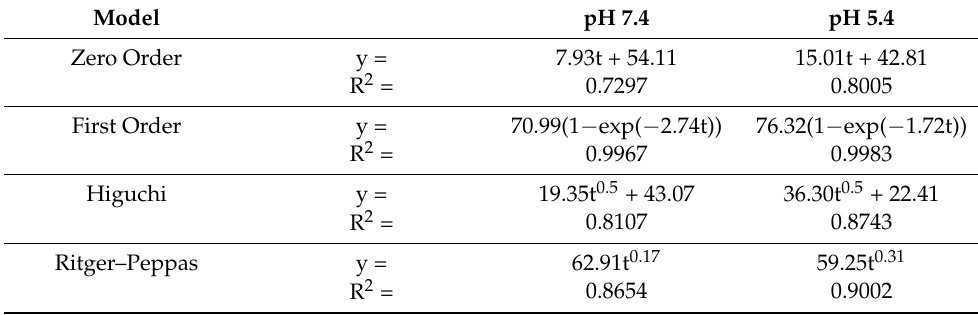
Table 2. Fitting parameters for the release models of RA-SFNs.